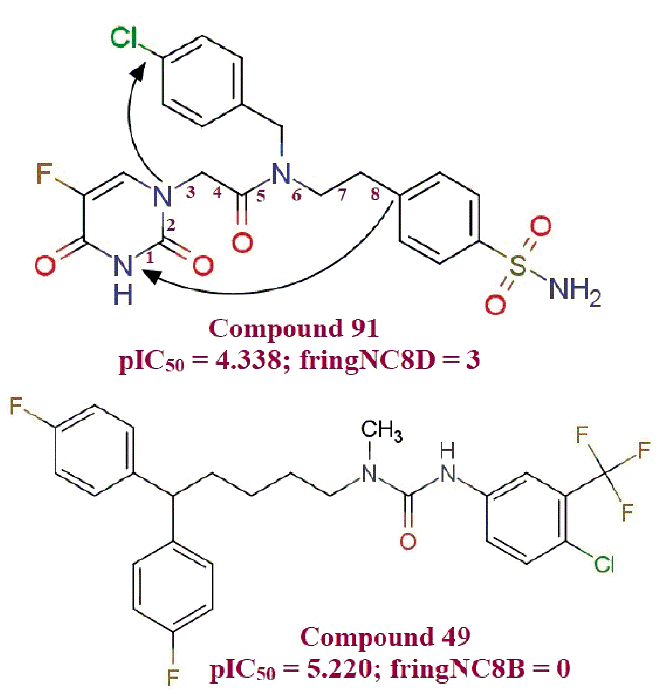
Figure 6. Illustration for molecular descriptor fringNC8B.